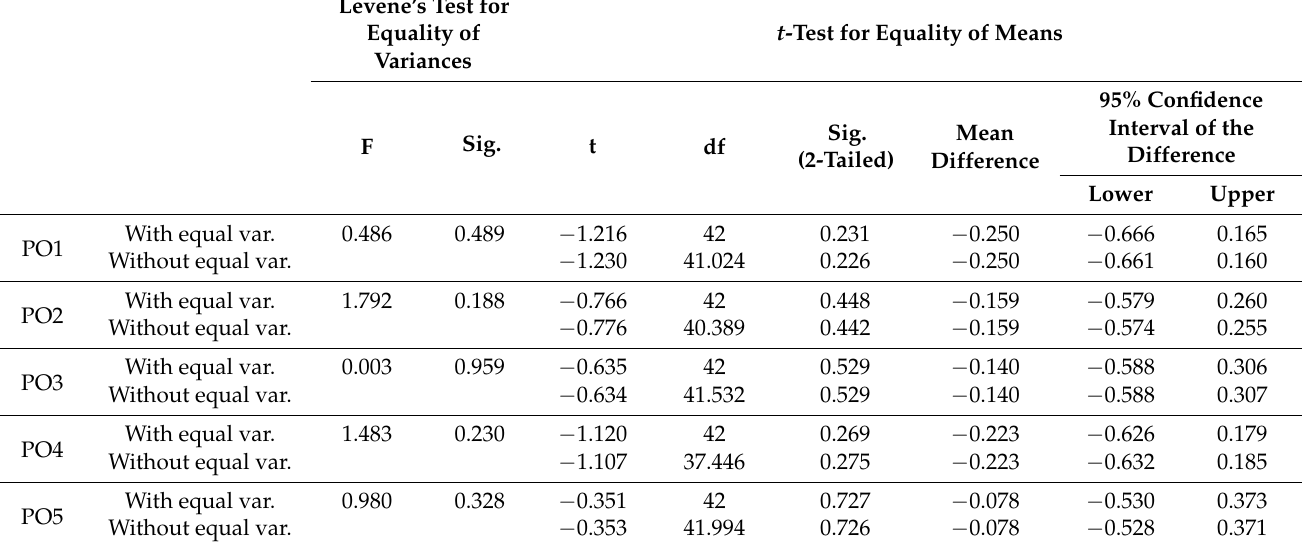
Table 5. Tutors’ observations toward students’ programming